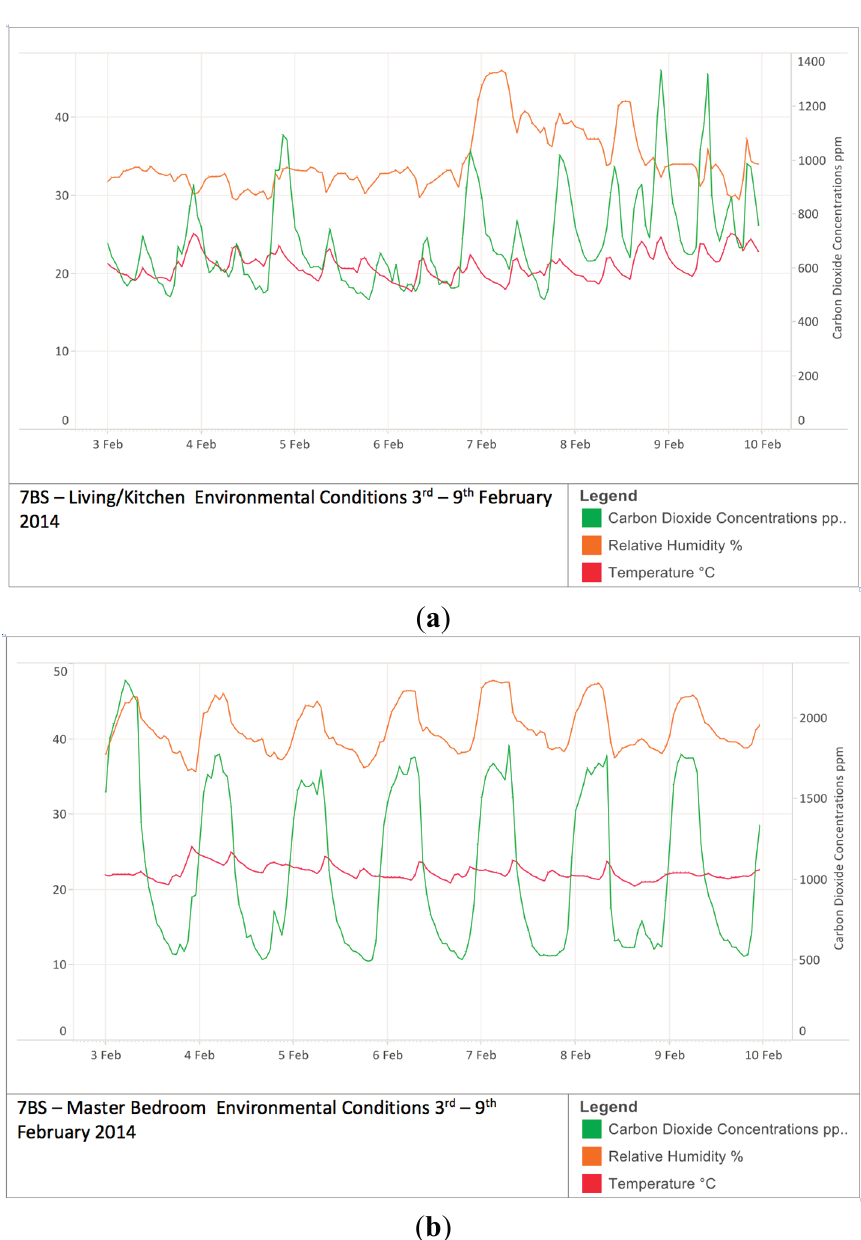
Figure 3. ( a ) Temperature, Relative Humidity and CO 2 levels living room ( b ) Temperature, Relative Humidity and CO 2 levels